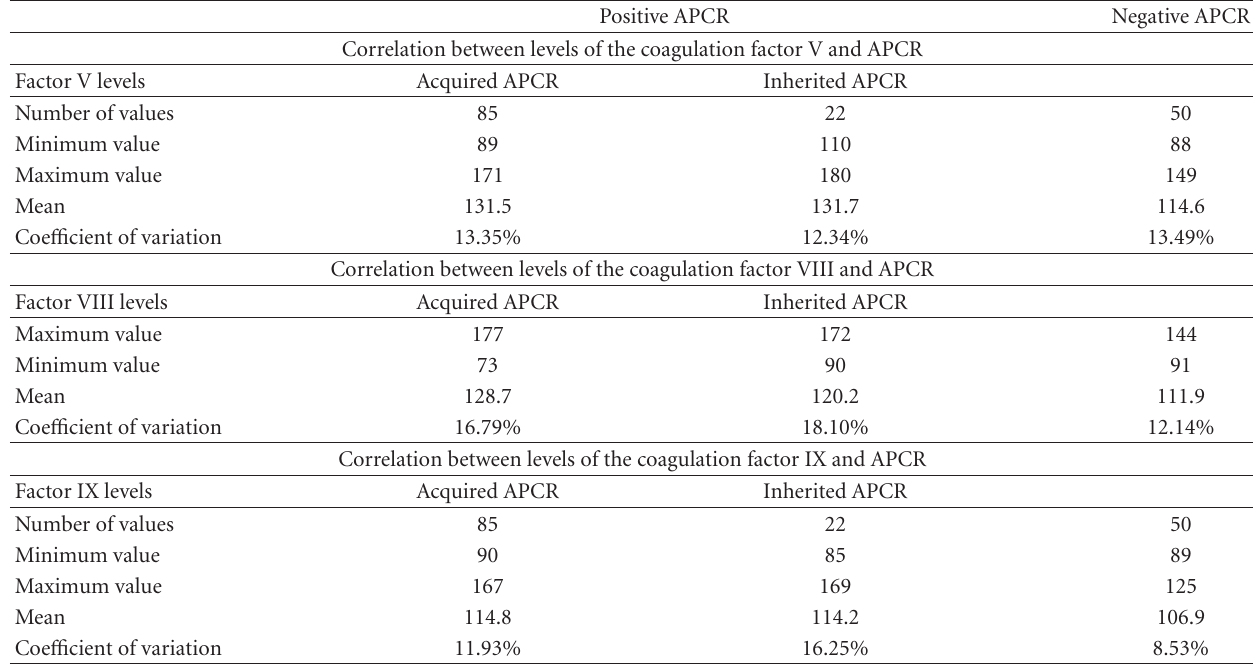
Table 2: Comparison of factor V, VII and IX in positive APCR acquired and inherited and negative APCR groups. Positive APCR Negative APCR